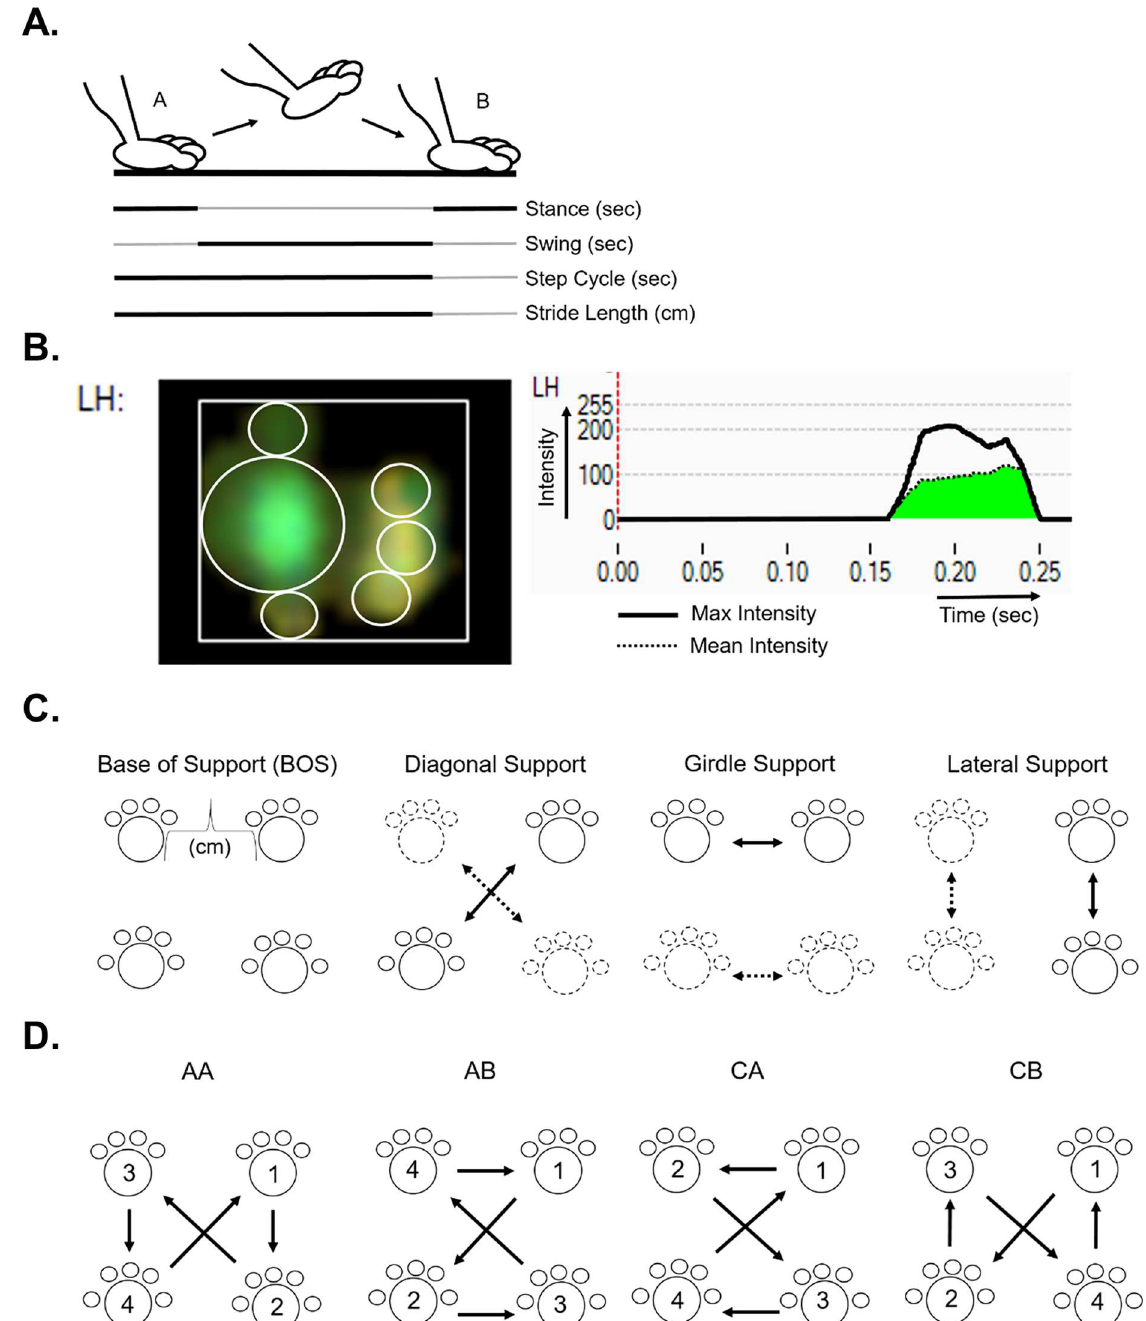
Fig 1. Gait metricoverview. (A) Single paw representationof gait cycle between point A and B along a walkway. Separategait metricsare definedby solid black lines withinthe gait cycle. (B) Screen captureimagesof the Noldus Catwalk System software showing printmeasurements and recordedintensitiesfor the left hind paw of a P448L mouse. Light displacement leaves a green paw printon the walkway as shown and is used to derive printsurface area metricsand intensity. The latteris an indicationof weight supportedby the paw. Intensityis measuredin real time, graphed and used to calculatethe highestintensitypixel in the print,Max Intensity(black line),and the Mean Intensityof all pixels (green area undercurve).(C) Summaryof supportmetrics. Solid printsand arrows represent a supportpair, the oppositepairsare represented as fragmentedprintsand arrows. (D) Common step patternsinclude the alternatepatternsAA and AB and the cruciatepatternsCA and CB. Numbersand arrows indicatestep order. The rightfrontpaw was arbitrarilychosen as the initial